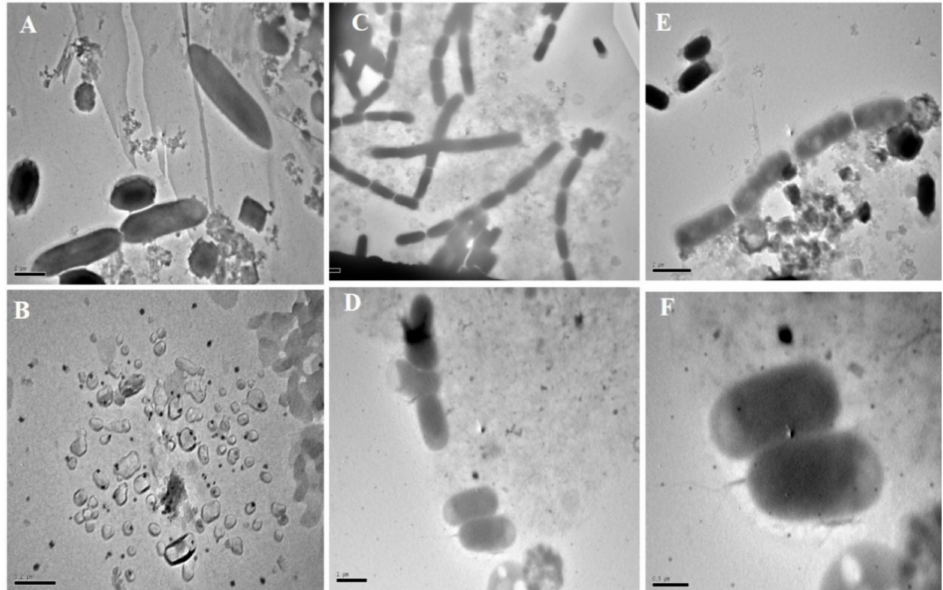
Figure 4. Effect of the tested compounds 3 , 12 , 13 , 14 and 16 on structural identity of Klebsiella sp. TEM Microgram of Klebsiella sp. (Control, ( A )) and presence of compounds 3 ( B ), compound 12 ( C ), compound 13 ( D ) and compound 14 ( E ) and compound 16 ( F